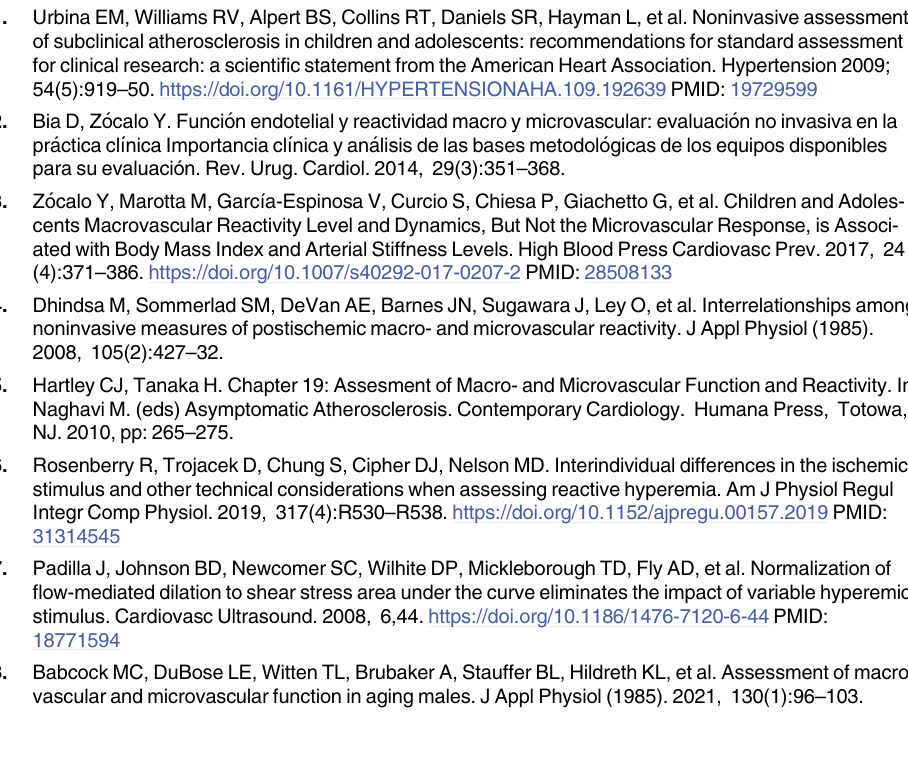
S2 File. Figure S1. Age-related profiles for vascular reactivity indexes: ´European criteria. Figure S2. Age-related profiles for vascular reactivity indexes: ´HUNT.FIT criteria.